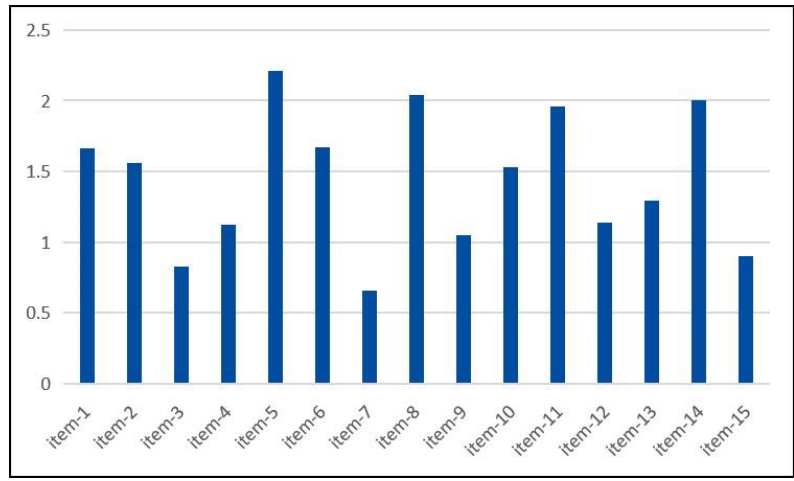
Figure 2. The mean score of each item of CFS. Note: CFS, cancer fatigue scale.